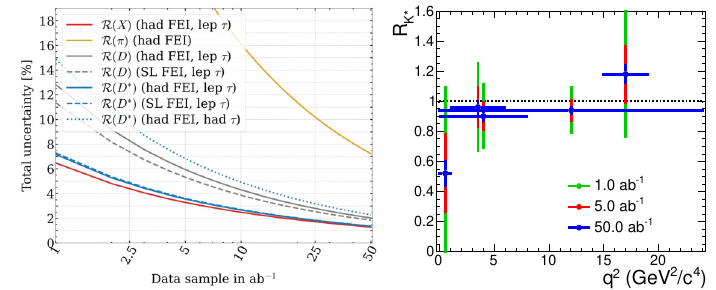
Figure 11. LFU prospects of Belle II for b → c (left) and b → s (right)